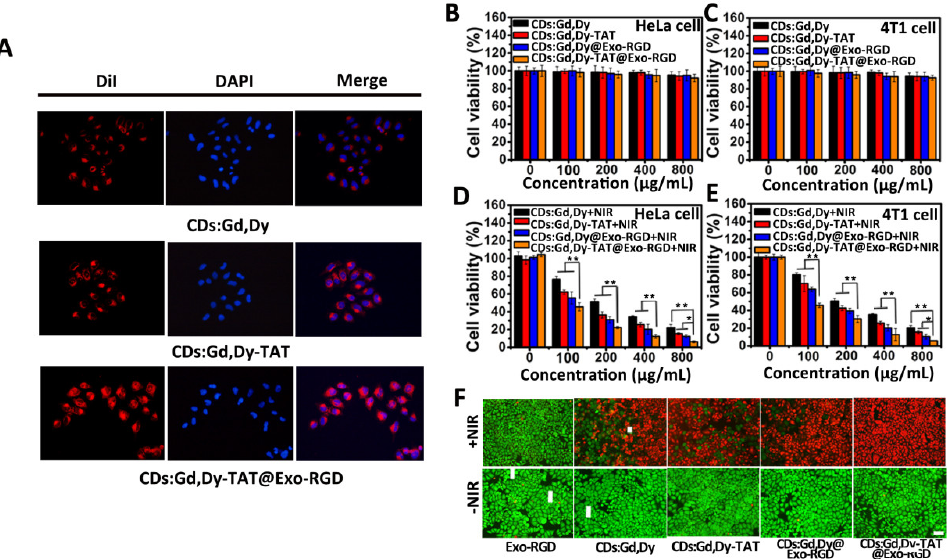
Figure 3. In vitro tumor cell targeting, nucleus penetration, cytotoxicity and photothermal perfor- mance. ( A ) DiI dye (red fluorescence)-labeled CDs:Gd,Dy, CDs:Gd,Dy-TAT or CDs:Gd,Dy- TAT@Exo-RGD was incubated with HeLa cells for 24 h, and DAPI was applied to dye the nucleus. The cell uptake was photographed through a fluorescence microscope, scale bar: 30 μm. ( B – E ) Via- bilities of HeLa cells and 4T1 cells co-incubated with CDs:Gd,Dy, CDs:Gd,Dy-TAT, CDs:Gd,Dy@Exo-RGD or CDs:Gd,Dy-TAT@Exo-RGD of different concentrations (CDs:Gd,Dy: 0, 100, 200, 400 and 800 μg·mL −1 ) with/without exposure to laser (1.6 W·cm −2 , 8 min). ( F )